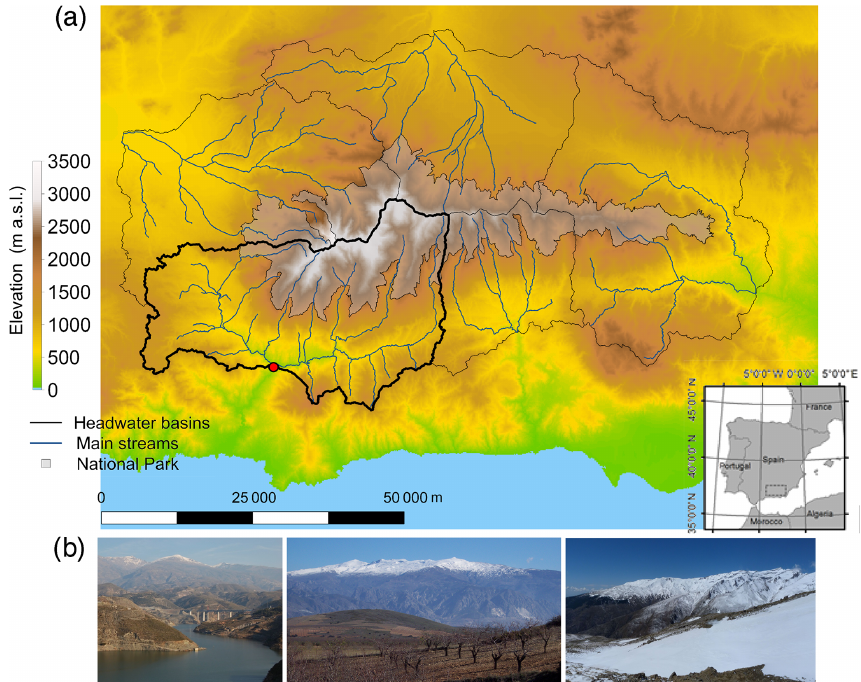
Figure 1. The Guadalfeo Experimental Catchment study site in Sierra Nevada (Spain). (a) Topography of the area, major fluvial streams and limits of the catchment (black line); the red circle corresponds to the Rules dam, the closure of the catchment, and the greyish area is the National Park domain. The inset shows the location in Spain. (b) Some representative